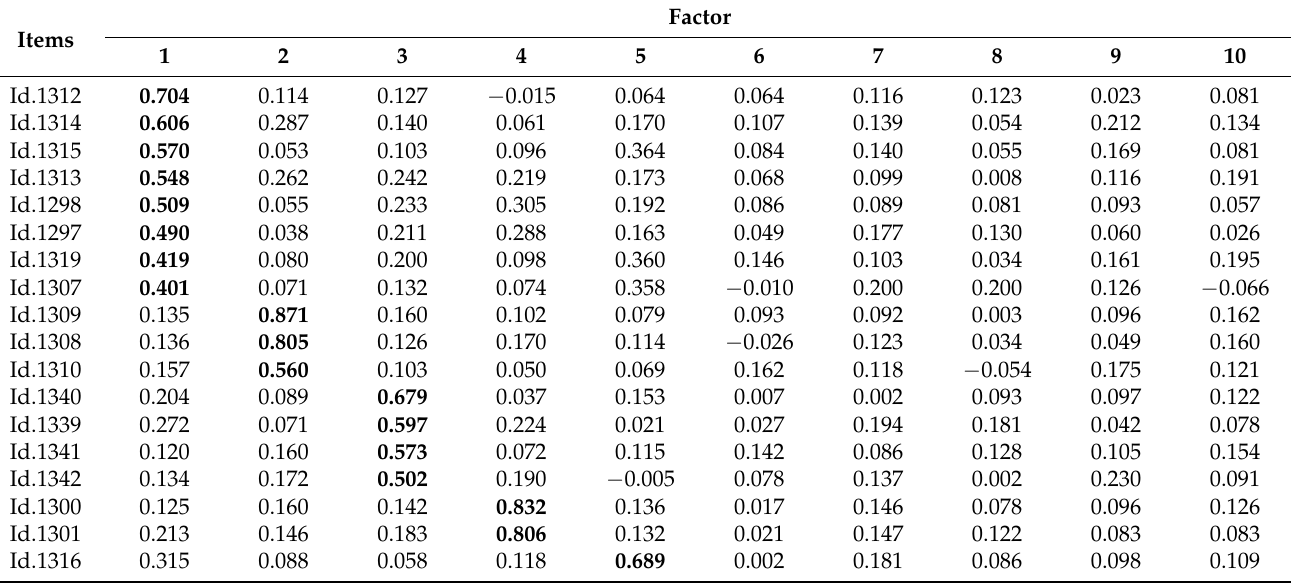
Table 2. This solution has passed the test of sphericity ( p < 0.001) and sampling adequacy (KMO = 0.882). The total variance retained by the solution is 74.4%. Table 2. Exploratory factor analysis (n = 444)—items related to the perceptual